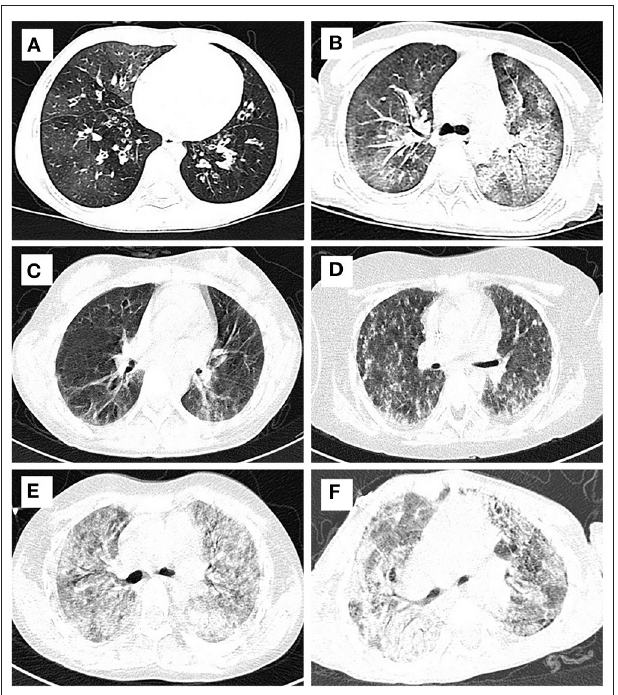
FIGURE 3 | Typical HRCT imaging of patients with DRC. Mosaic perfusion, interlobular septal thickening and ground glass opacity from bronchiolitis obliterans (A) and alveolar proteinosis (B) ; reticular and linear opacities and pleural thickening from juvenile dermatomyositis (C) and pulmonaty fibrosis (D) ; ground glass opacity, interlobular septal thickening, and reticular & linear opacities from diffuse alveolar hemorrhage syndromes (E) and Sting associated with vasculopathy with onset in infancy (F)